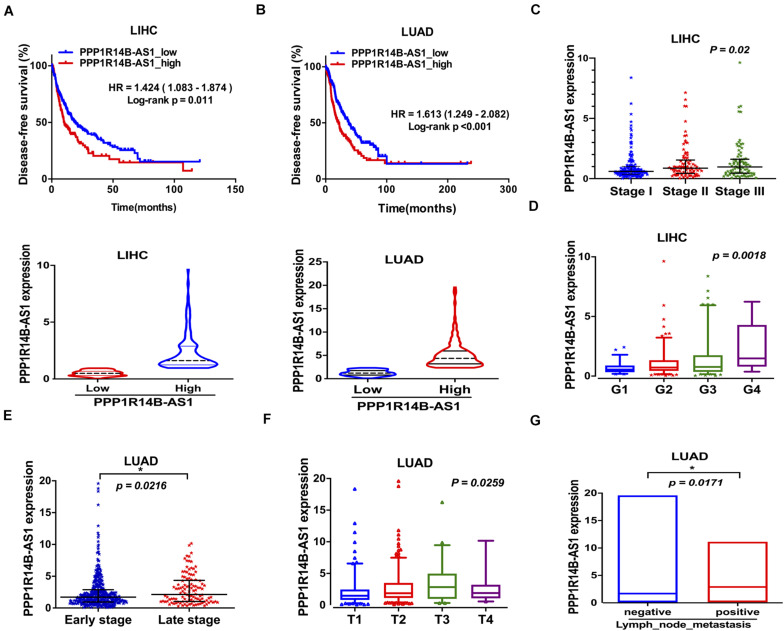
PPP1R14B-AS1 participated in LIHC and LUAD progression. (A,B) Patients with LIHC or LUAD were divided into two groups in accordance with PPP1R14B-AS1 RNA-seq FPKM values, and Kaplan–Meier survival analyses were conducted to analyze disease-free survival. HR values were calculated with the R package “survival,” and data were analyzed through log-rank test. (C) PPP1R14B-AS1 expression in patients with Stage I (n = 171), Stage II (n = 86), and Stage III (n = 85) LIHC, one-way ANOVA. (D) PPP1R14B-AS1 expression in patients with tumor grade 1 (n = 55), grade 2 (n = 177), grade 3 (n = 122), and grade 4 (n = 12) LIHC, one-way ANOVA. (E) PPP1R14B-AS1 expression in patients with early stage (Stage I + Stage II, n = 395) and late-stage (Stage III + Stage IV, n = 110) LUAD, Mann–Whitney test. (F) PPP1R14B-AS1 expression in primary tumors with different sizes and extents in patients with LUAD (T1, n = 168; T2, n = 276; T3, n = 47; T4, n = 19), one-way ANOVA. (G) PPP1R14B-AS1 expression in patients with negative (n = 330) and positive (n = 171) lymph node metastasis, Mann–Whitney test. *p < 0.05.